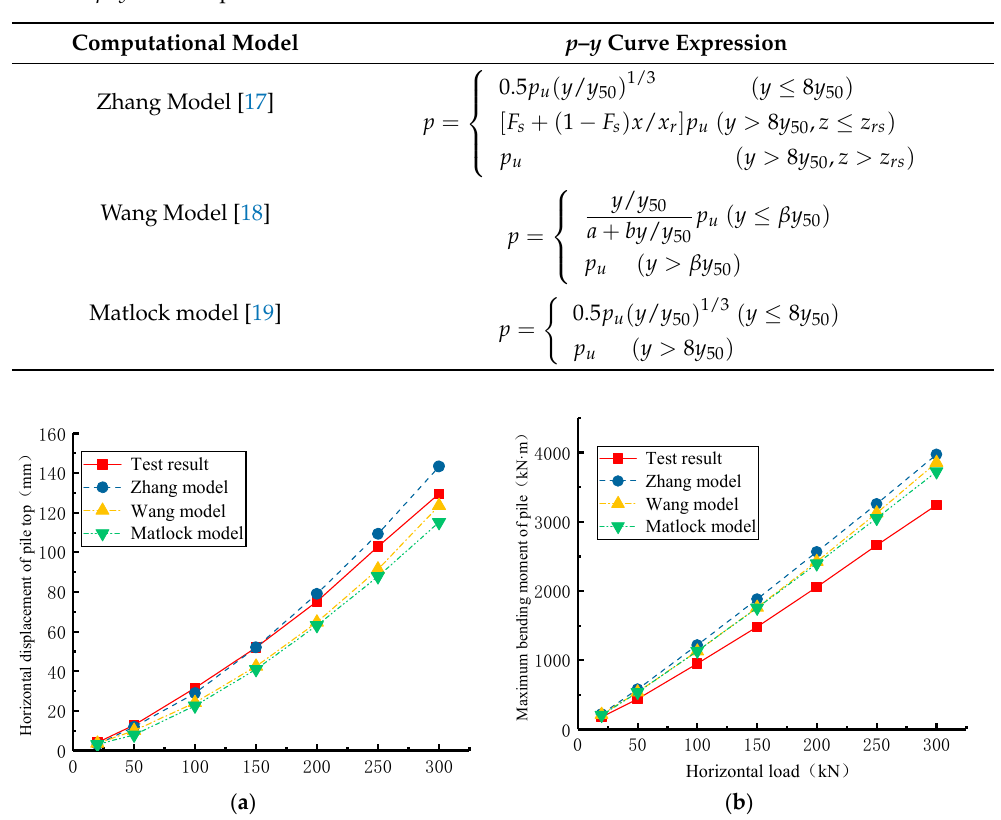
Table 1. p – y curve expression.